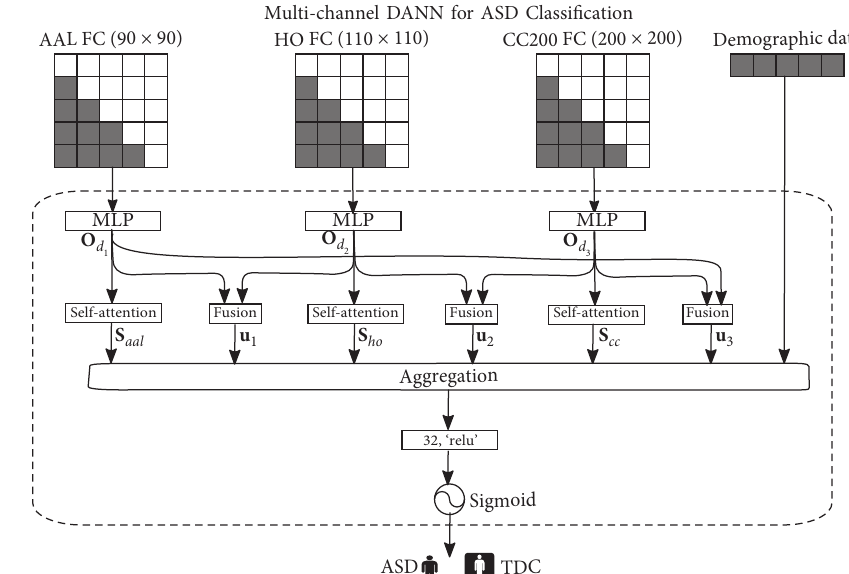
Figure 1: A DANN structure for ASD classification in this study.